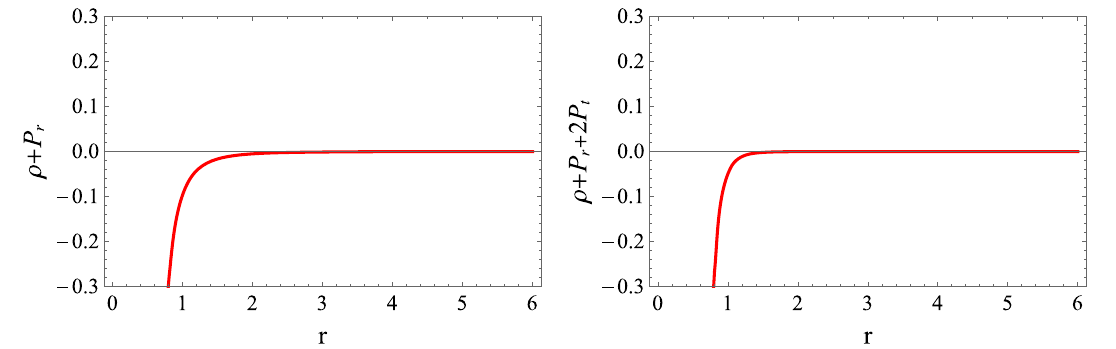
Fig. 8 Plots for NEC and SEC diagrams in the left and right panel against radial coordinate depending on the shape function b ( r ) = r ( r 0 / r ) n + 1 . The results seem NEC and SEC are violated throughout the spacetime. We use the numerical values α = 0 . 1 and r 0 = 1 along with n = 1,